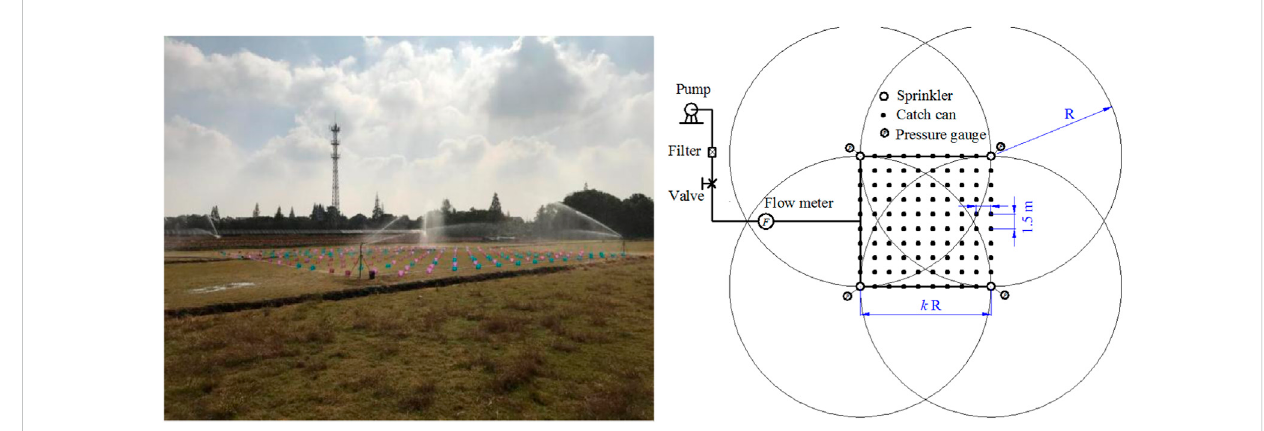
FIGURE 4 Schematic and pictorial view of sprinkler